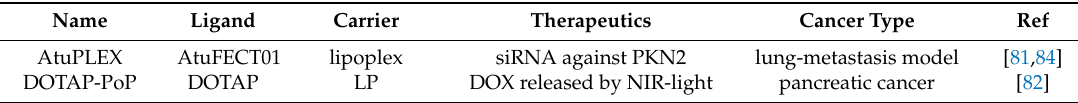
Table 5. Cation-mediated